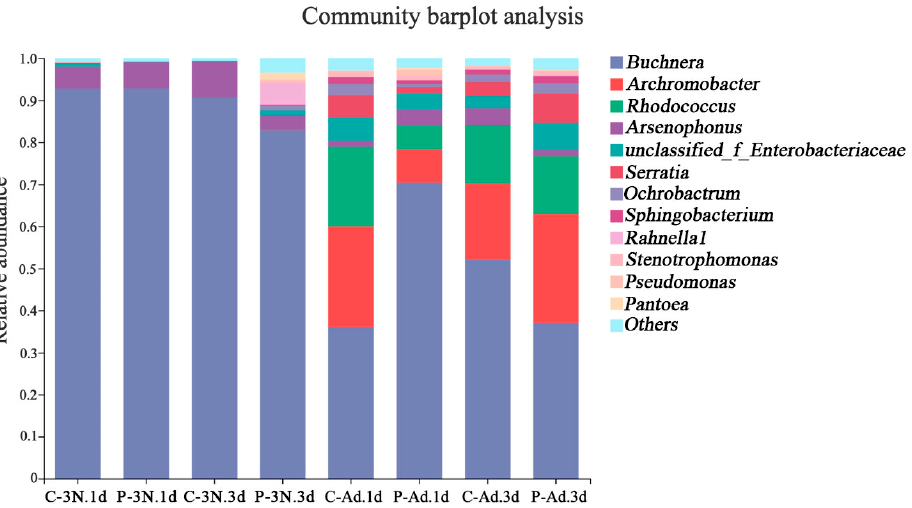
Figure 3. Bacterial community composition plots in parasitized and unparasitized A. Bar chart showing the relative abundance of dominant bacterial genera (over gossypii ovaries. Bar chart showing the relative abundance of dominant bacterial genera (over 1%).